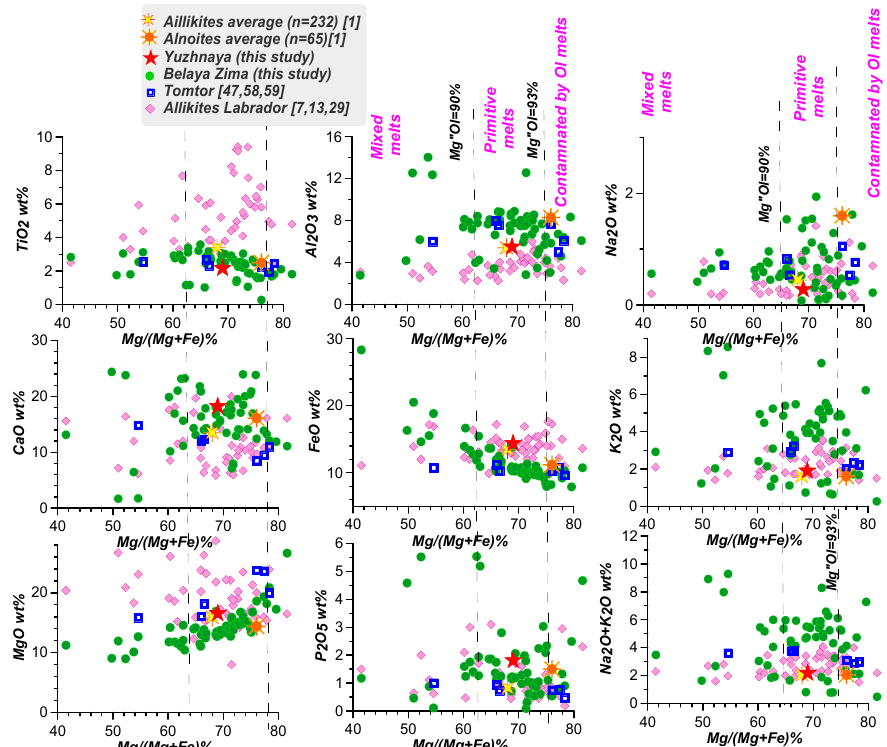
Figure 10. Variations of the major components versus Mg’ for BZM aillikites, see explanation in the text.